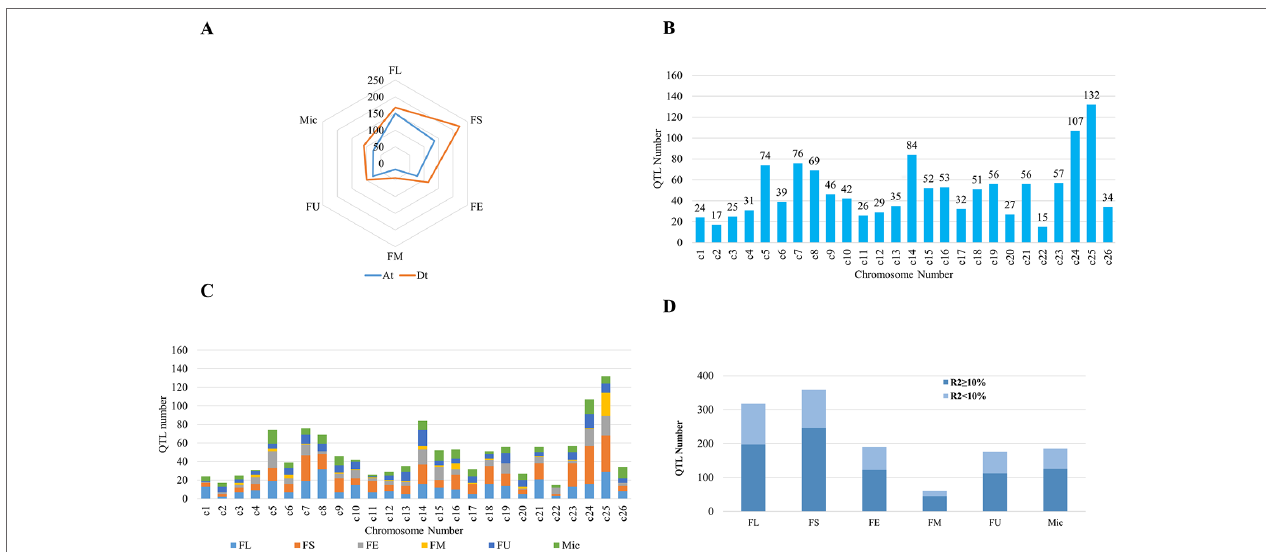
FIGURe 2 | Quantitative trait loci (QTLs) distributed across each chromosome in cotton genome. (A) QTLs of fiber quality traits distributed across At and Dt sub- genomes. (B) QTLs mapped in each chromosome. c1–c26 represents chromosome 1 to chromosome 26, respectively. (C) QTLs for different fiber quality traits. FL, fiber length; FS, fiber strength; FE, fiber elongation; FM, fiber maturity; FU, fiber uniformity; Mic, micronaire. (D) The variance (R2) explained by a single QTL related to fiber quality traits. FL, FS, FE, FM, FU, Mic. The same as used above.